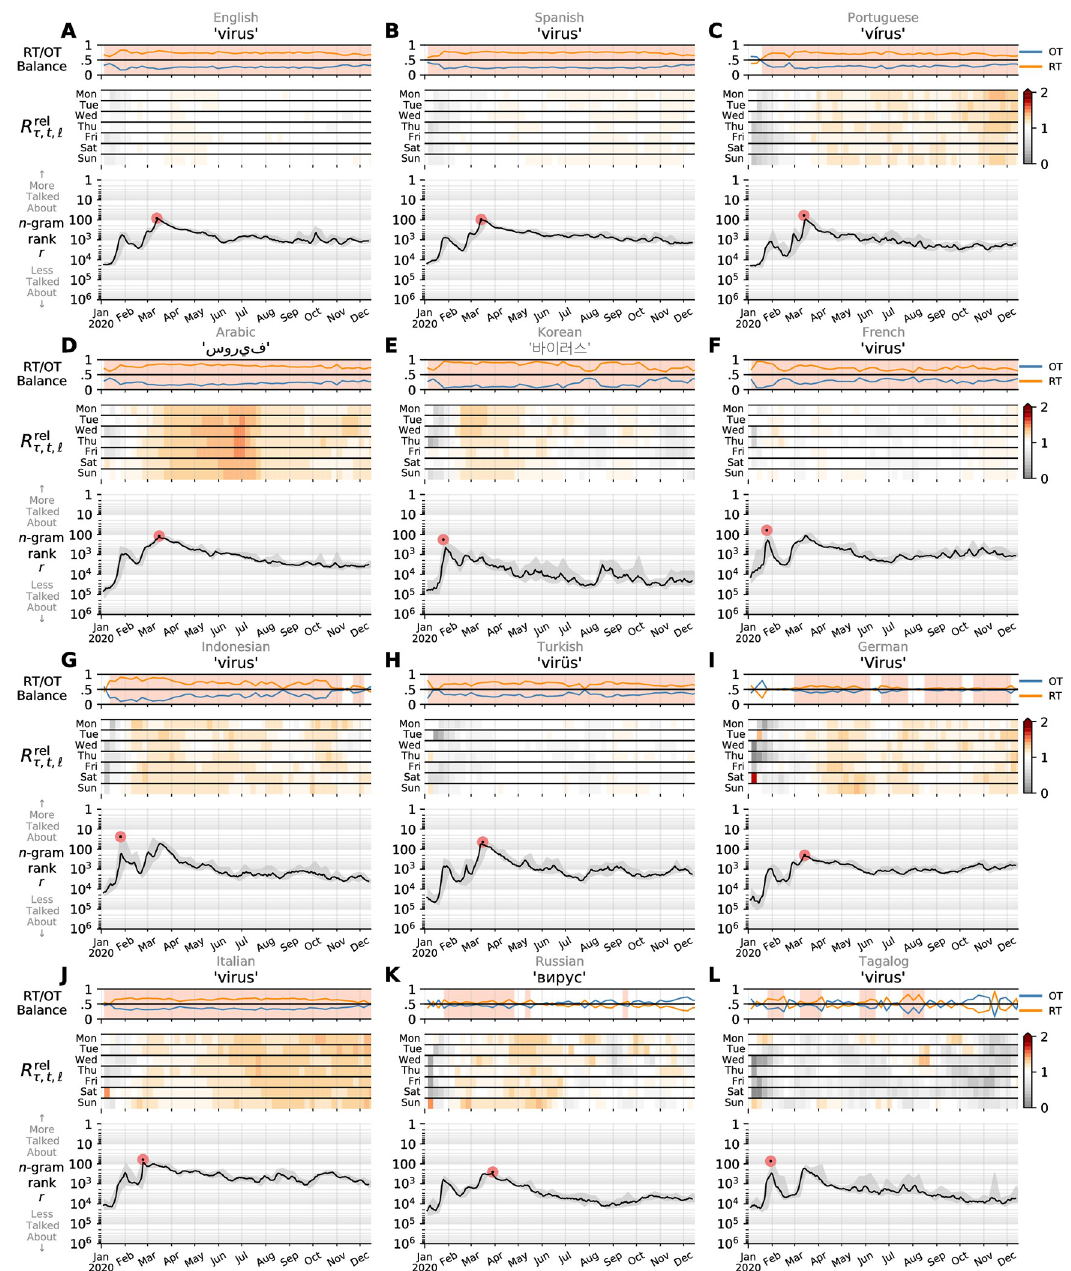
Fig 4. Contagiograms for the word ‘virus’ in the top 12 of the 24 languages we study here. The major observation is that the world’s attention peaked early in late January around the news of an outbreak of a new infectious disease in Wuhan, declining through well into February before waking back up. The main plots in each panel show usage ranks at the day scale (ET). The solid lines indicating smoothing with a one week average (centered). The plots along the top of each panel show the relative fractions of each 1-gram’s daily counts indicating as to whether they appear in retweets (RT, spreading) or organic tweets (OT, new material). The background shading shows when the balance favors spreading—story contagion. See Fig 5 for the next 12 languages, as well as Sec. Results and discussion for general discussion, and Alshaabi et al. [29] for technical details of contagiograms.